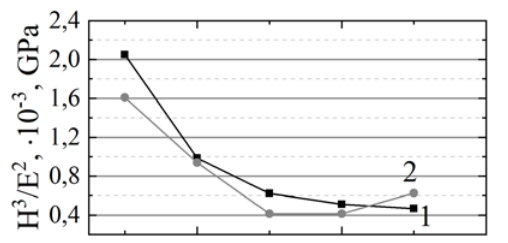
Figure13. Modification of the plasticity index, H/E , as it moves away from the friction surface “metal/abrasive”. Curve 1 - friction for 1 hour; curve 2 - 5 hours.